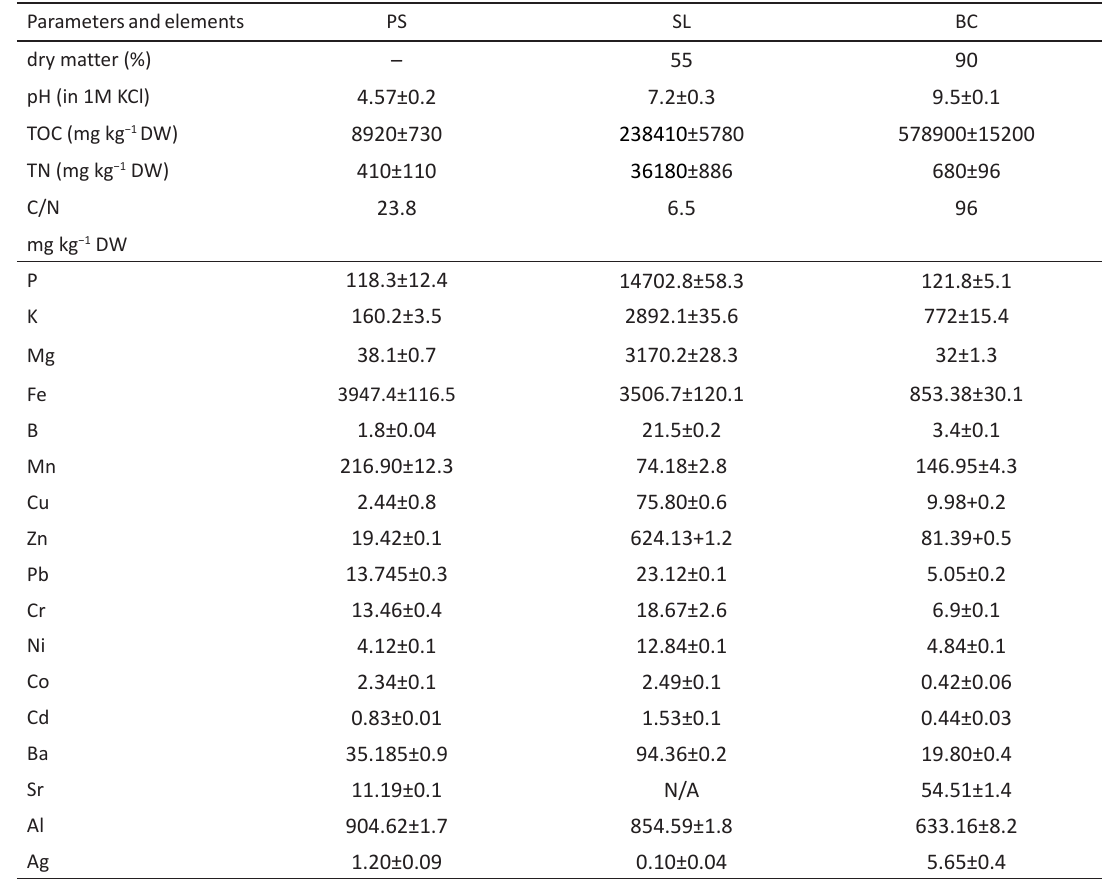
Table 1. Chemical properties of control soil (podzolic soil-PS), sewage sludge (SL) and biochar (BC) used in the experiment (mean, ± SD, n = 3) Parameters and